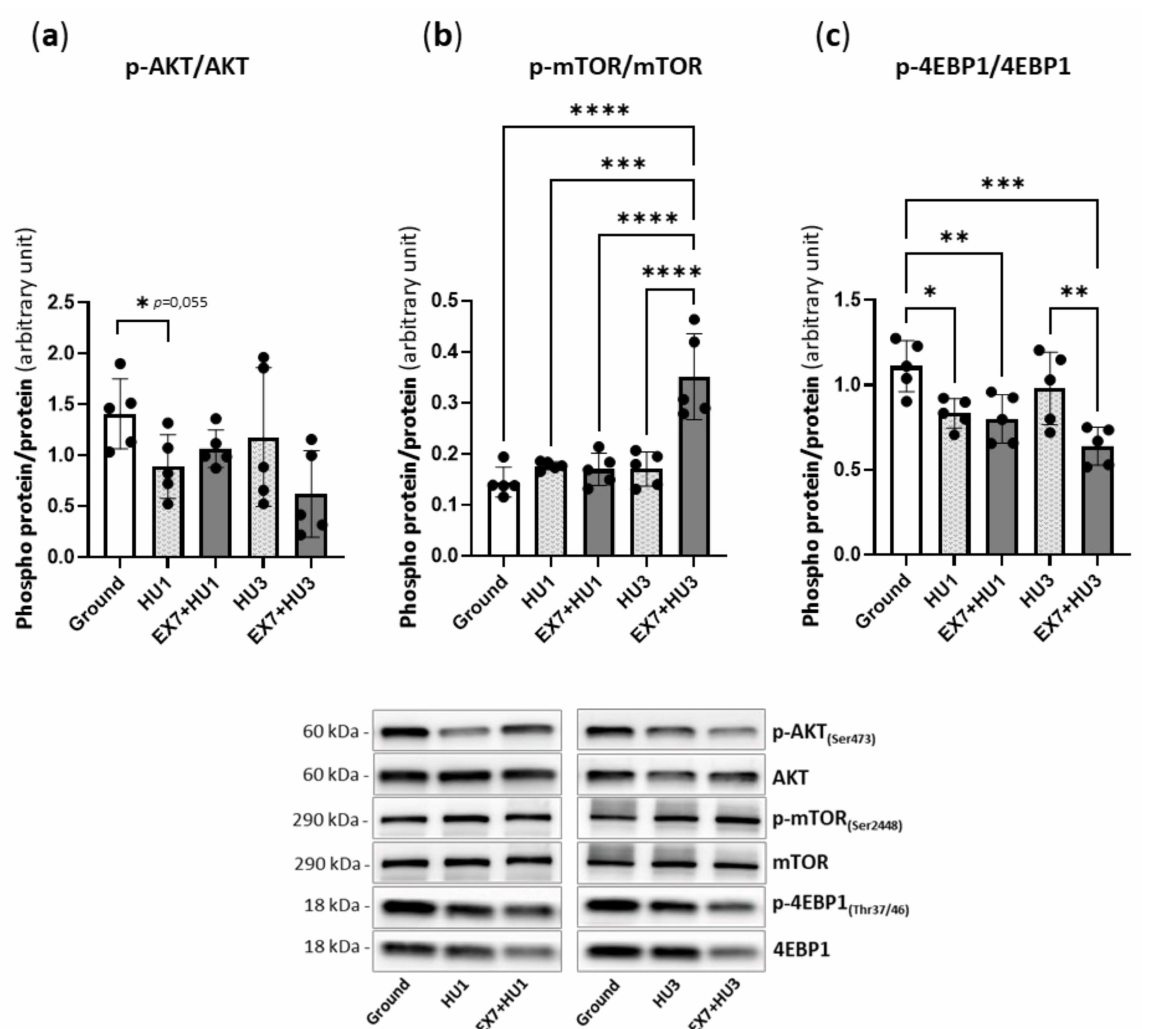
Figure 4. Physical preconditioning effect on phosphorylation of kinases of the Akt/mTOR pathway during disuse. Determination of activity levels of p -AKT ( a ), p -mTOR ( b ), and p -4EBP1 ( c ) by Western blot analysis of the ratio between the content in the phosphorylated ( p ) and total forms and relative representative Western blot. Ground: Control mice ; HU1: Mice subjected to 1 day of hindlimb unloading; EX7 + HU1: Mice subjected to 7 days of physical preconditioning followed by 1 day of hindlimb unloading; HU3: Mice subjected to 3 days of hindlimb unloading; EX7 + HU3: Mice subjected to 7 days of physical preconditioning followed by 3 days of hindlimb unloading. Data are presented as means ± SD * p < 0.05 ** p < 0.005 *** p < 0.0005 **** p <